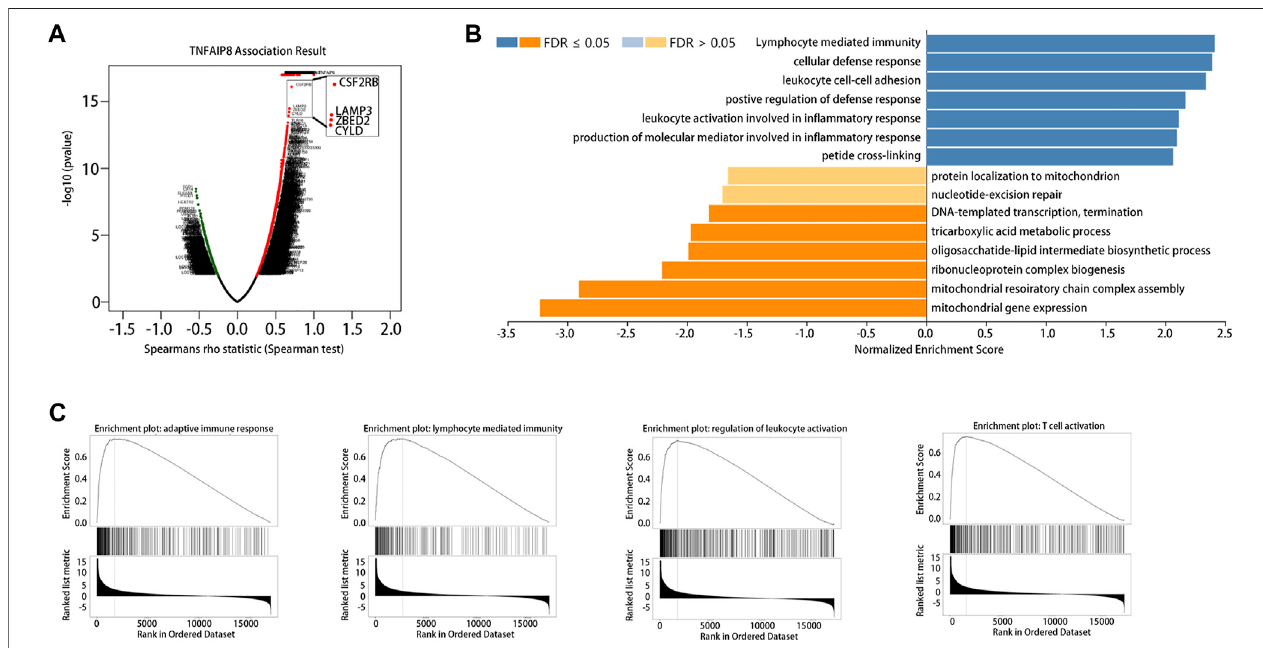
FIGURE 6 | Gene set enrichment analysis (GSEA) of TNFAIP8 in SKCM. (A) Volcano plot of all differentially expressed genes. (B) Signi fi cantly enriched biological processes of GSEA annotations of TNFAIP8 in SKCM (LinkedOmics). (C) GSEA enrichment plots of speci fi ed biological